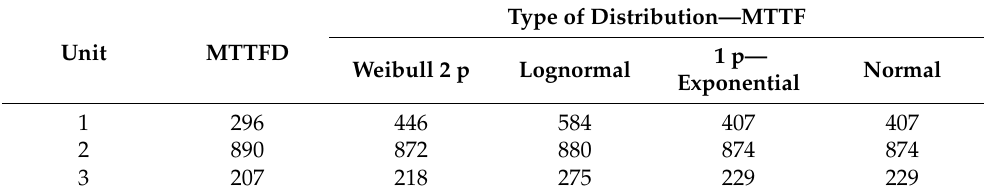
Table 2. The comparison of experimental MTTF D with MTTF estimated from the chosen probability distributions.